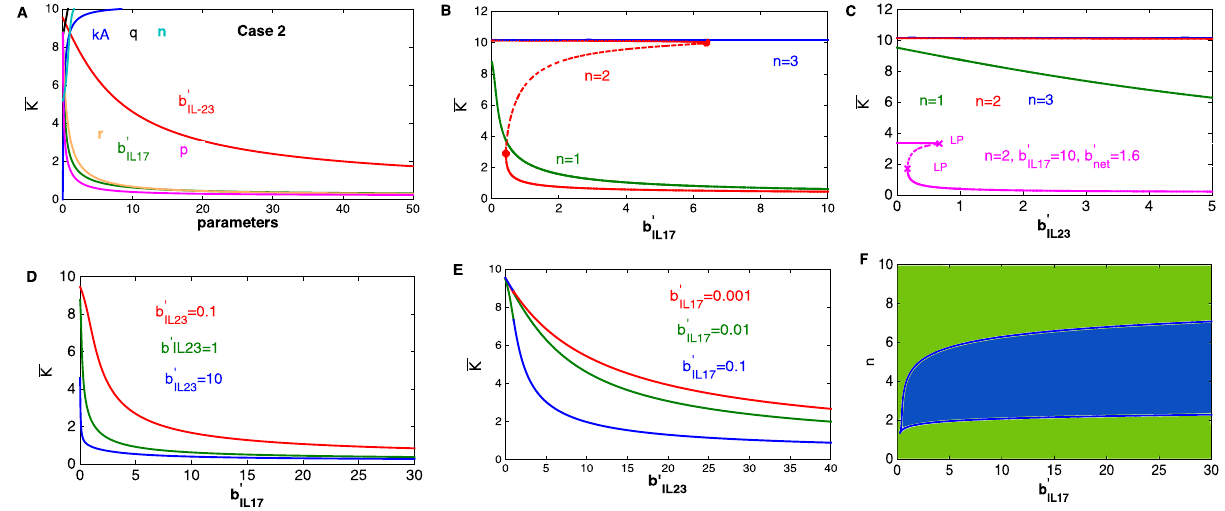
Figure 4. The signal response curve for the subnetwork mediated by IL-17 and IL-23 (Fig. 1C) in the case 2 scenario. ( A ) Steady state population of keratinocytes for varying model parameters. ( B ) Bistable response of keratinocyte population for changes in the level of IL-17. ( C ) For parameter combinations as in Fig. 3, bistability ′ = 10 , b ′ = 1.6 and n = 2 could lead to a bistable behavior. would not be observed. However, changing b net IL 17 ( D ) Effect of the present level of IL-23 on the steady state response of the keratinocyte population for changing levels of IL-17. ( E ) Modulatory effect of the present level of IL-17 on the steady state response of the keratinocyte population for varying levels of IL-23. ( F ) The separation of the two parameter space spanned by the level of IL-17 and the Hill coefficient (n) in monostable (green) and bistable (blue) regions. Model parameters as in ′ = 10 , b ′ = 1.6 and n = 2. Fig. 3 except in ( C ) where b net IL 17